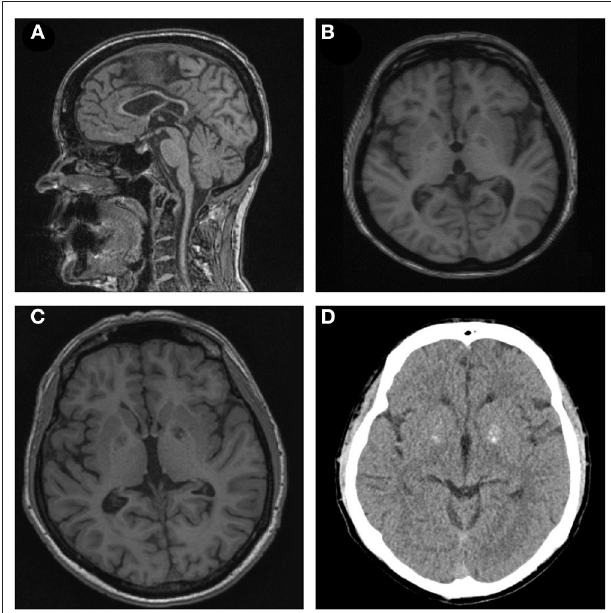
FIGURE 2 | (A,B) Sagittal T1-weighted brain magnetic resonance imaging (MRI) of patient II-1 demonstrating thin corpus callosum. Axial T1-weighted brain MRI of subject I-1 depicting cortical atrophy. (C,D) T1-weighted MRI and CT scan of subject II-2 showing basal ganglia calcification.